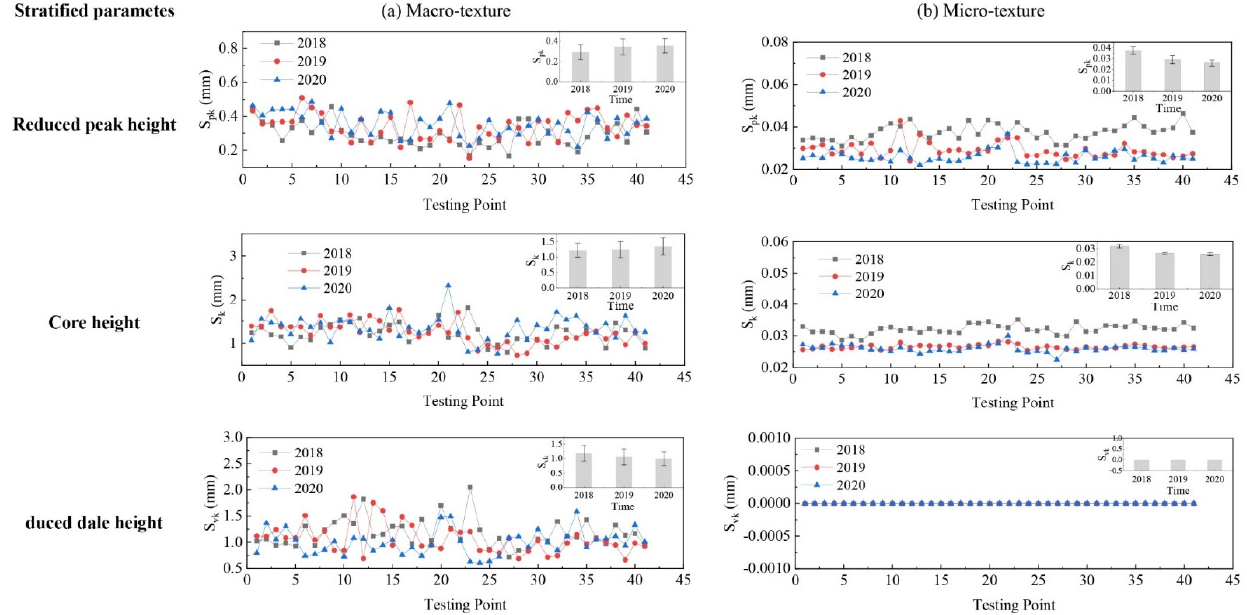
Figure 12. Pavement texture variations via stratified parameters: ( a ) Macro − texture, and ( b ) Micro − texture.